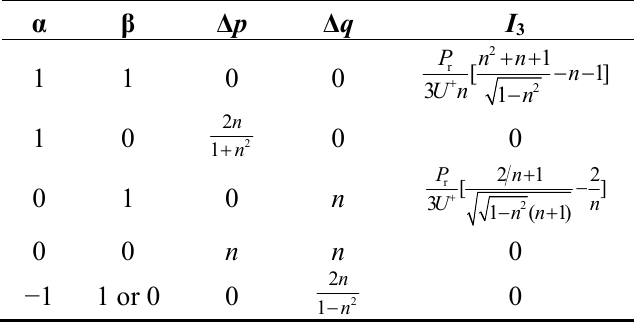
Table 1. Power fluctuation and 3rd harmonic current characteristic under different